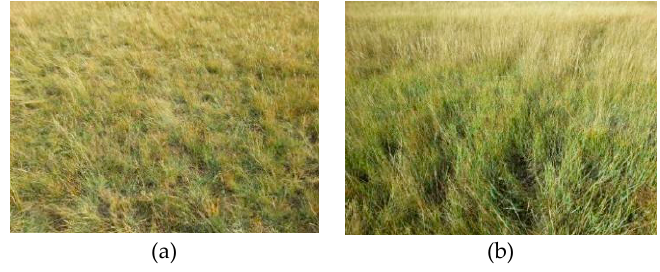
Figure 8. Vegetation condition in Plot 1 ( a ) and Plot 2 ( b ).